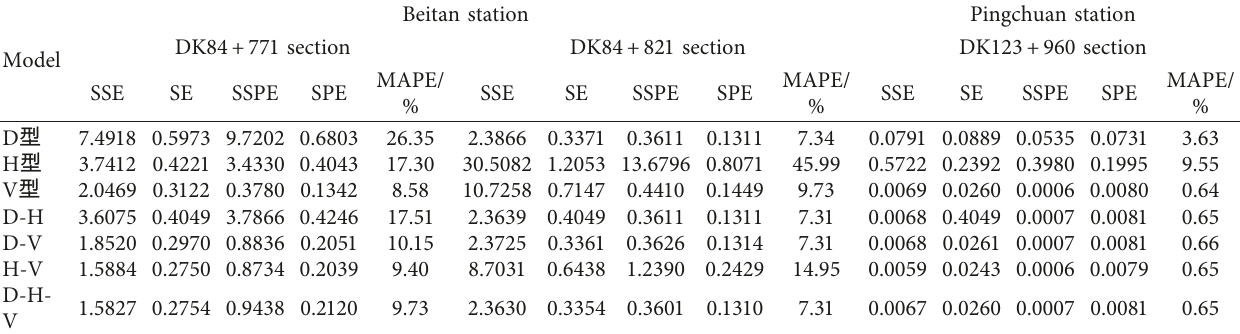
Table 5: Comparison of precision index values of each prediction model.